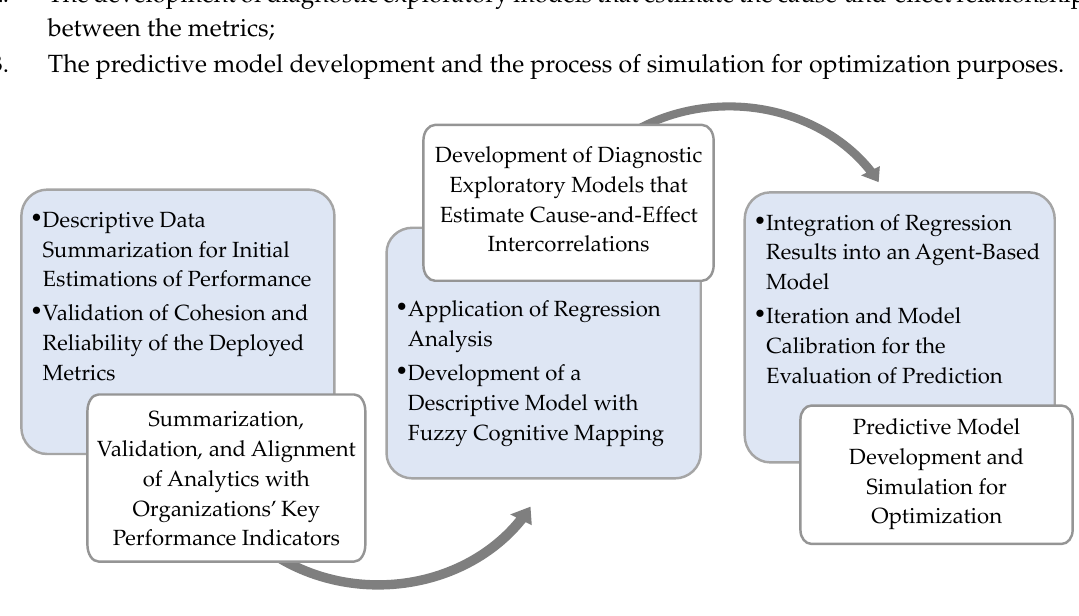
Figure 6. Representation of the proposed methodological approach. Each step supports the analysts and decision-makers of cultural institutions to retrieve, validate, organize, and utilize big data analytics in order to improve their online visibility and findability.